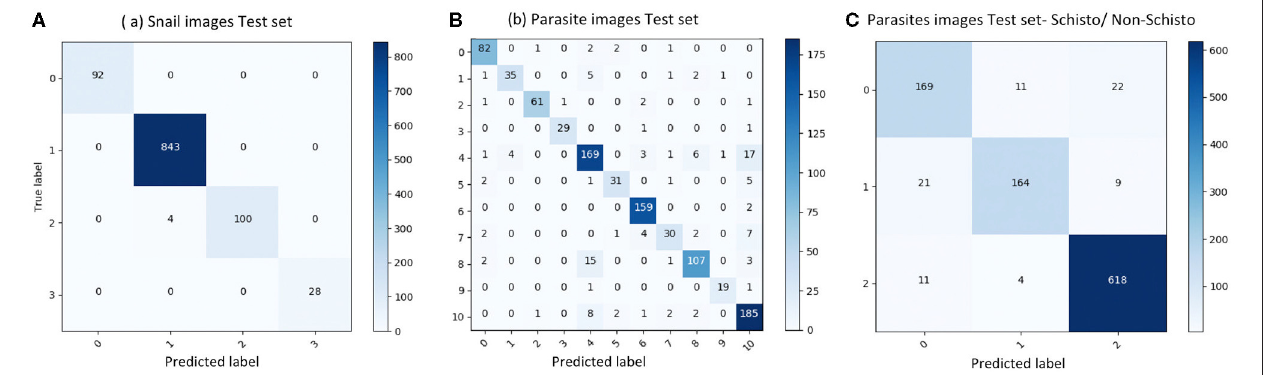
FIGURE 3 | Confusion matrix of classification on test set. (A) results of snail image set, labels: 0- Biomphalaria spp., 1: Bulinus spp., 2: Radix natalensis , 3: Melanoides spp. (B) results of parasite image set, labels: 0: Amphistome cercariae, 1: Schistosoma bovis , 2: Echinostome cercariae, 3: Gymnocephalus cercariae, 4: Human-schisto, 5: Metacercaria, 6: Parapleurolophocercous cercariae, 7: Parthenitae, 8: Non-human- schisto forktail type I, 9: Non-human- schisto forktail type II, 10: Xiphidiocercariae. (C) Combining other trematodes as one category, labels: 0: Schisto, 1: Non-human forktail type I, type II, and bovis , 2: Other